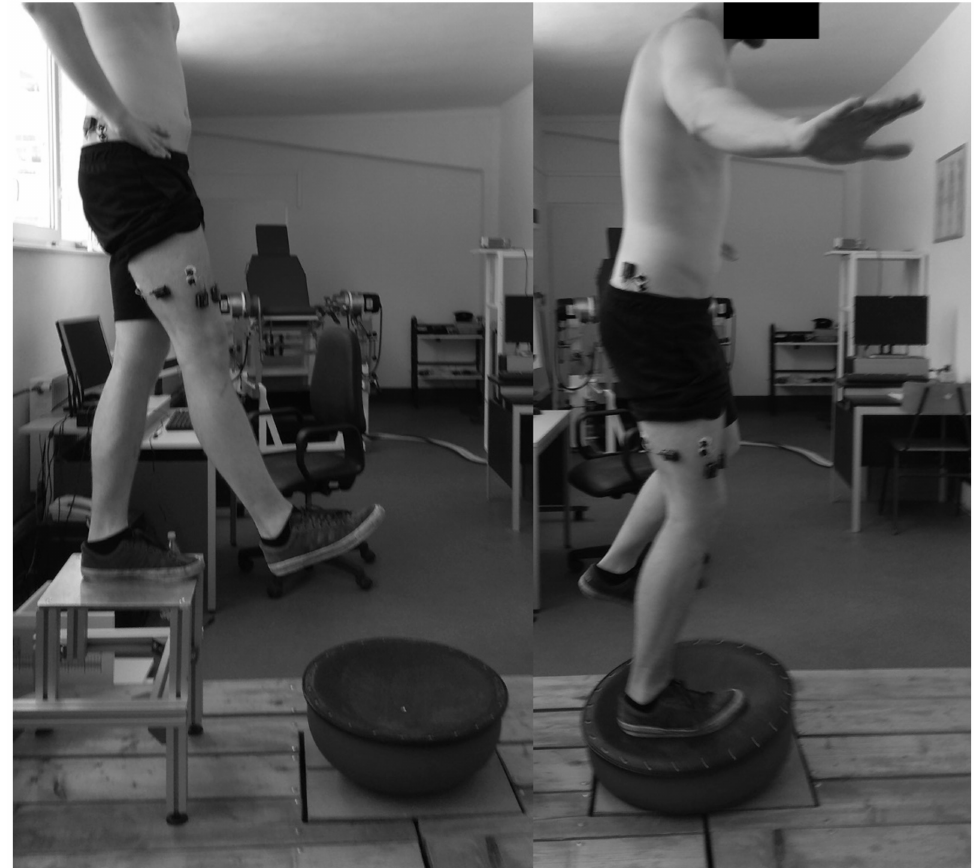
Figure 1. Landing task performed to the flat side of a TOGU ®